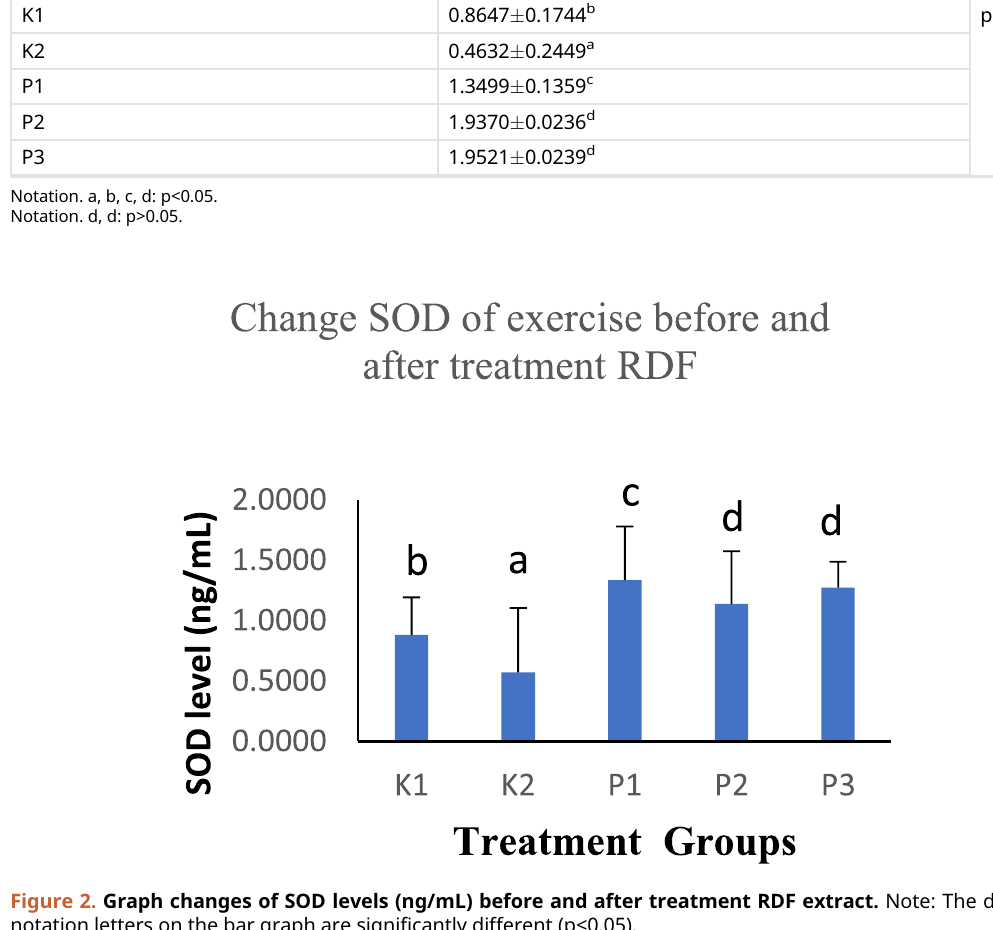
Table 3. Comparison of the results of the SOD level before and after treatment RDF extract. Groups